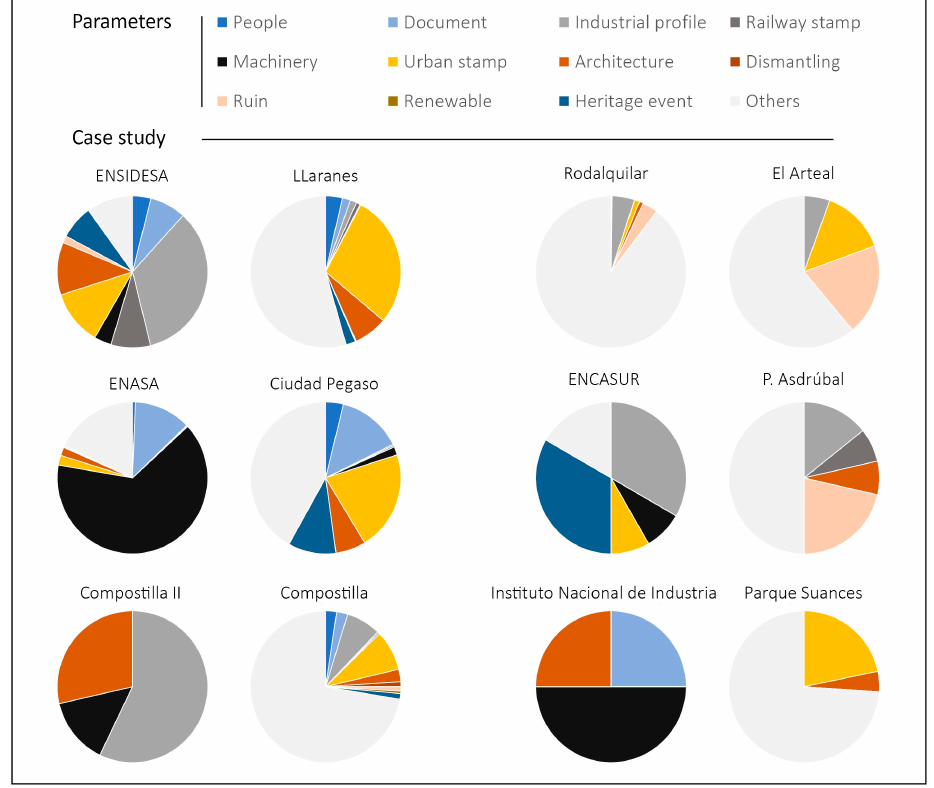
Figure 2. Pie charts relating to public content of the selected case studies found on Instagram.